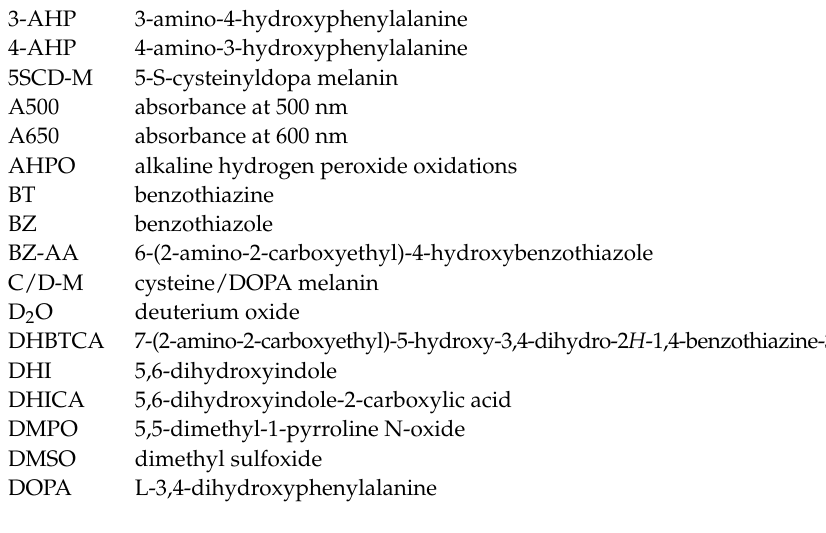
Table S2: Chemical analysis of isolated pigments. Table S3: Chemical analysis of isolated pigments. Table S4: Chemical analysis of isolated pigments. Table S5: Values of initial intensities of oxygen consumption by the studied melanins. Table S6: Values of initial velocities of DMPO-OOH formation by the studied